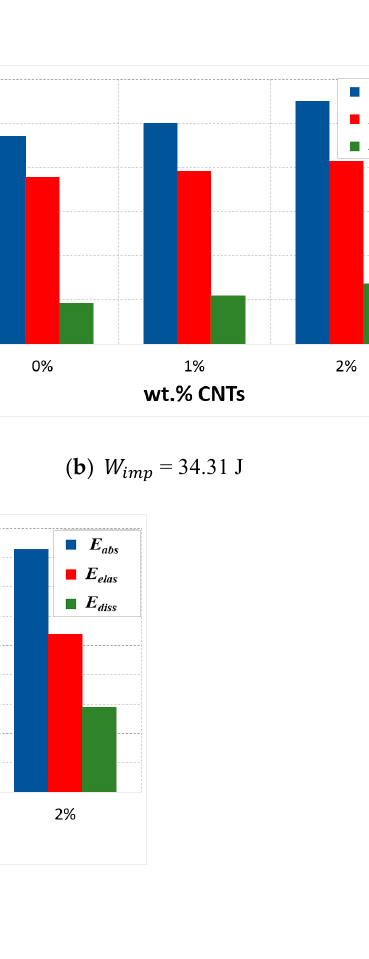
Figure 10. Energy balance vs. CNT mass fraction at different impact energies.